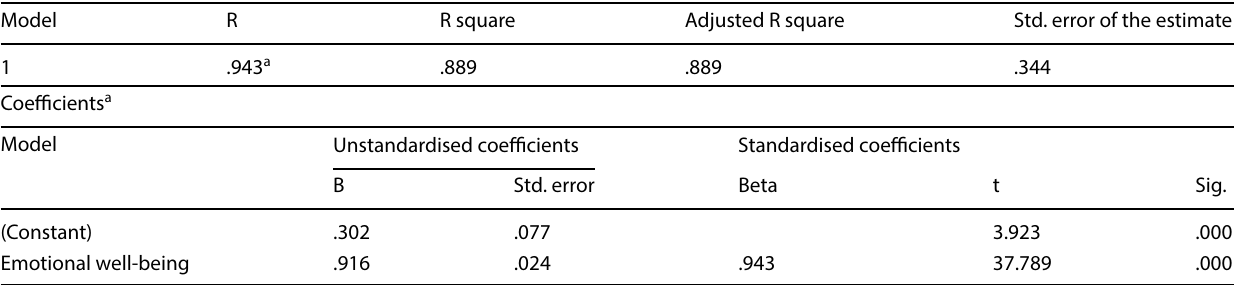
Table 8 Model summary